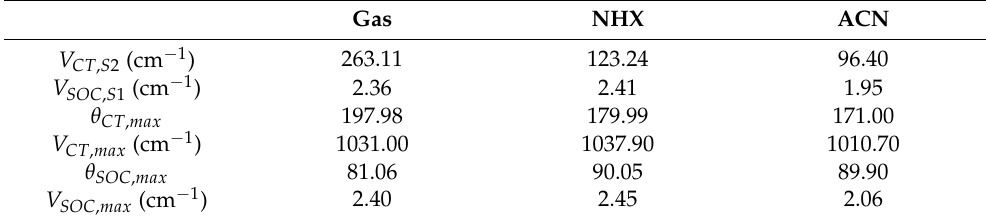
Table 6. The spin–orbit and electronic coupling at the optimized geometries. The value of the maximum SOC value near an orthogonal geometry and the maximum electronic coupling near 180 ◦ . The geometries are calculated with TZP and the CAMY-B3LYP